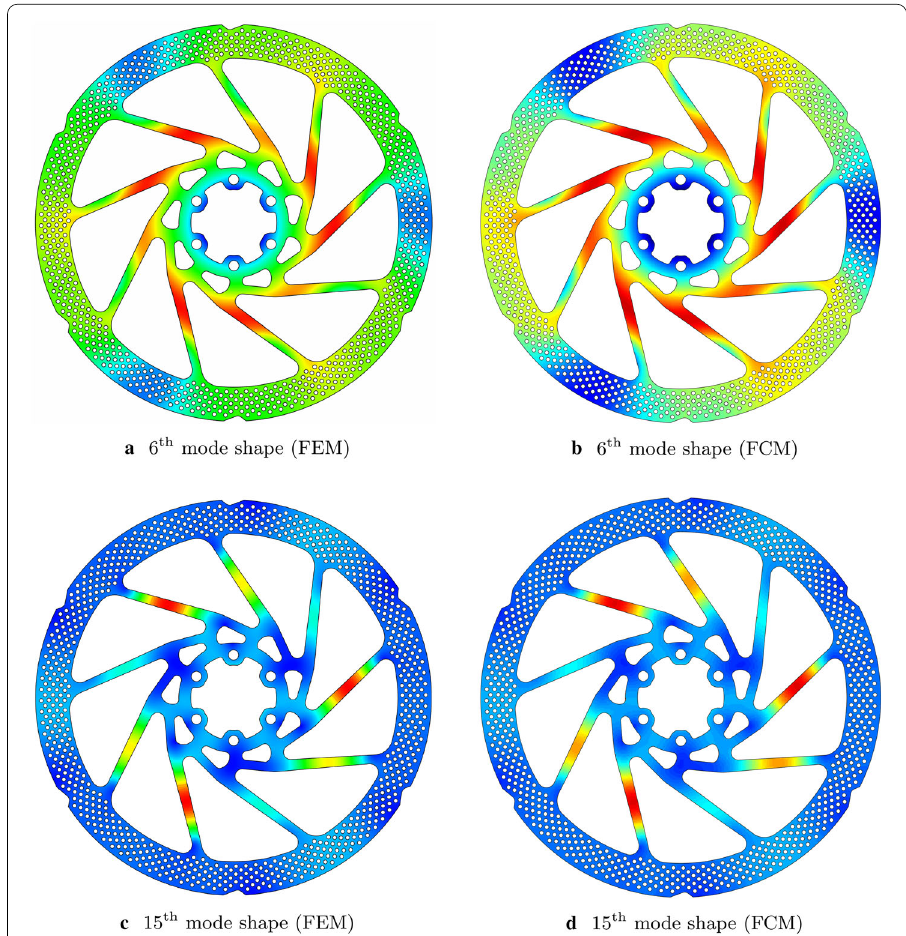
Fig. 31 Visualization of the 6th ( a , b ) and 15th mode shapes ( c , d ) with the eigenfrequencies 16,796 Hz and 26,651 Hz, respectively. The color indicates the magnitude of the normalized displacement vector ( u max = 1)